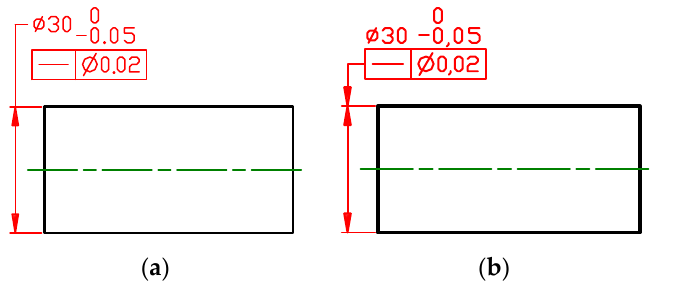
Figure 4. ( a ) Shaft with straightness tolerance for derived median line and size tolerance (ASME Y14.5); ( b ) shaft with straightness tolerance for derived median line and size tolerance (ISO GPS). Local sizes are defined differently.